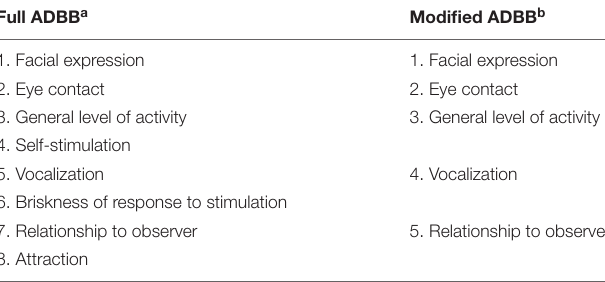
TABLE 1 | Overview of the full and modified Alarm Distress Baby (ADBB)